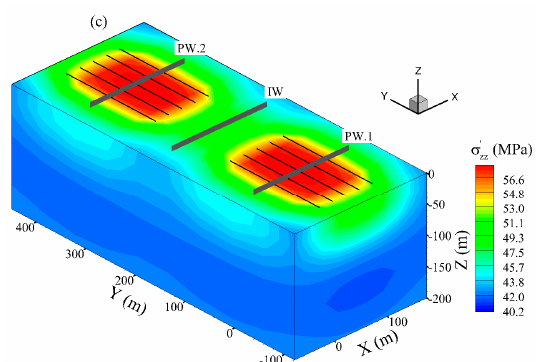
Figure 15. A 3D visualization of effective stress change around the “Parent” and “Infill” wells after 2 years of production: ( a ) effective horizontal stress component 𝜎 (cid:3051)(cid:3051)(cid:4593) , ( b ) effective horizontal stress component 𝜎 (cid:3052)(cid:3052)(cid:4593) , ( c ) effective vertical stress 𝜎 (cid:3053)(cid:3053)(cid:4593) . In situ effective stresses at the wellbore level: 𝜎′ (cid:3023) = 40.2 MPa, 𝜎′ (cid:3009) = 24.8 MPa , 𝜎′ (cid:3035) = 21.4 MPa.